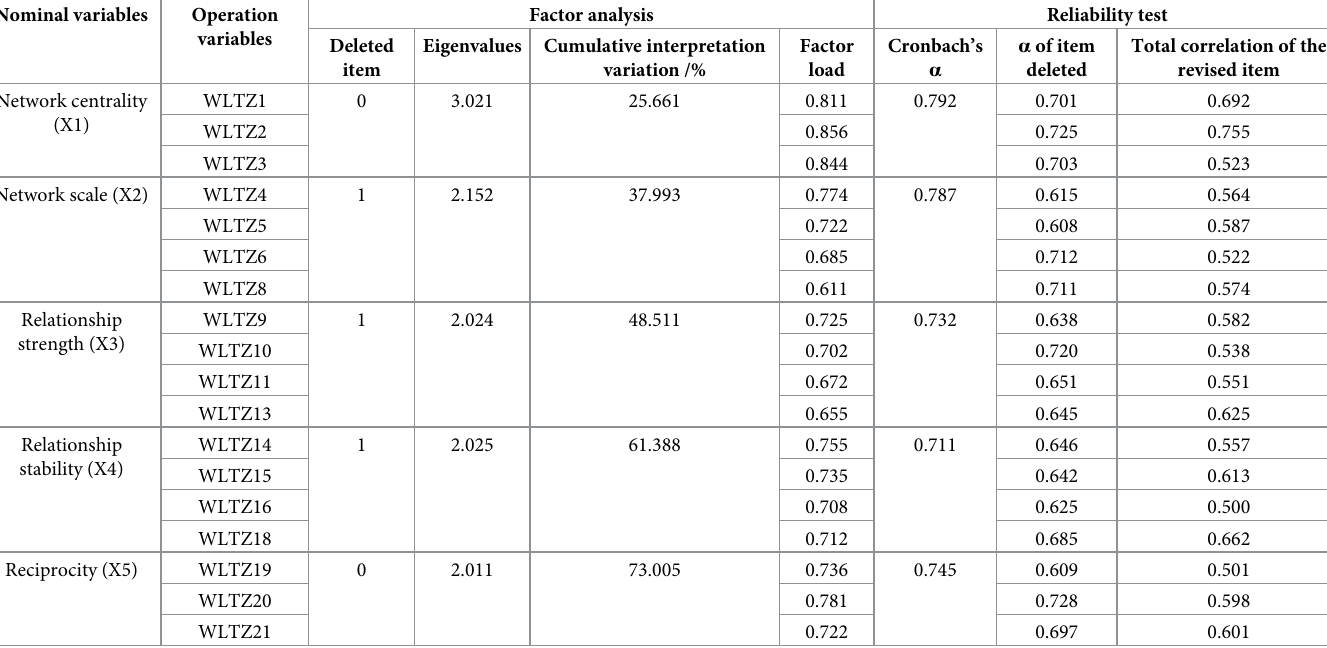
Table 7. Factor analysis and reliability test scale results of the innovation network characteristics.